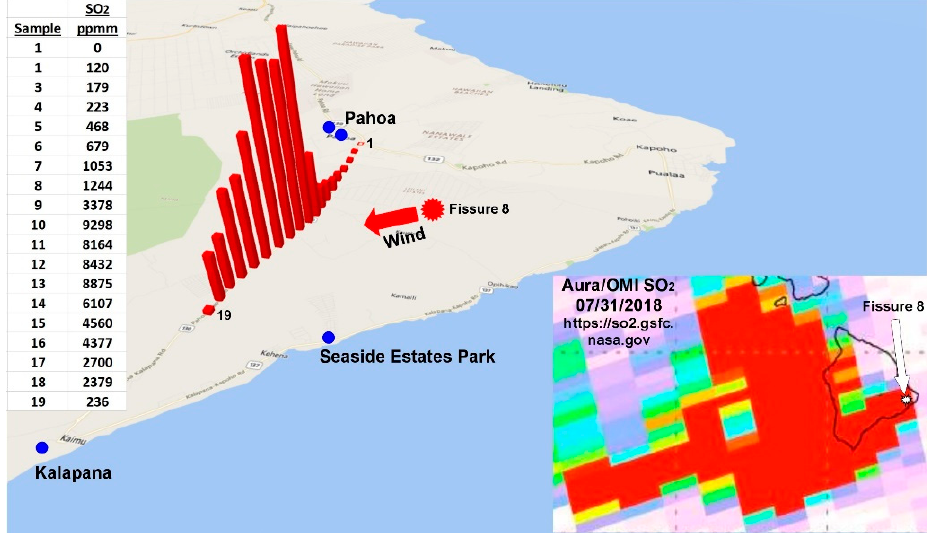
Figure 10. SO 2 (ppmm) measured by a UV spectrometer during a traverse along a highway adjacent to the eruption plume from Fissure 8 of the Kilauea volcano on 31 July 2018. The inset is an Aura/Omi image of SO 2 over and downwind from Hawai’i Island on the same day. In the inset, Kilauea’s Fissure 8 is indicated by the red dot in the large map and by a white arrow in the inset at lower right.